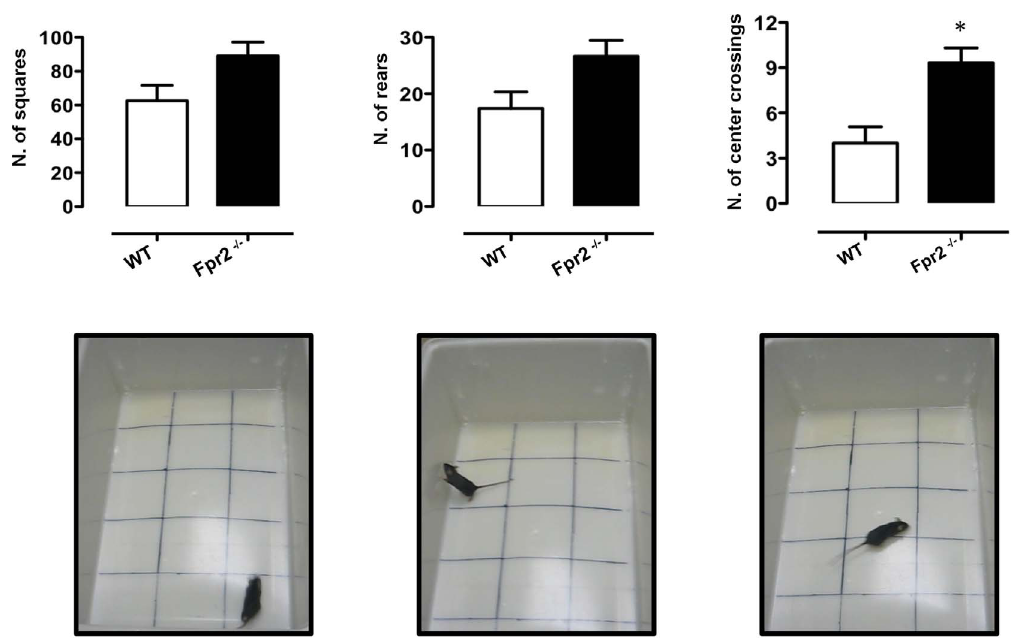
Fig. 1. Reduced anxiety-like behaviour of Fpr2/3 -/- mice in the open field test. The bar graphs and images show total number of squares crossed, rears and centre crossings during a 5-minute session. Values are expressed as median ¡ S.E.M. and representative of four experiments, each involving 6–9 mice per group. * P , 0.05 indicate significant values compared with wild-type (WT) control mice (Mann–Whitney U